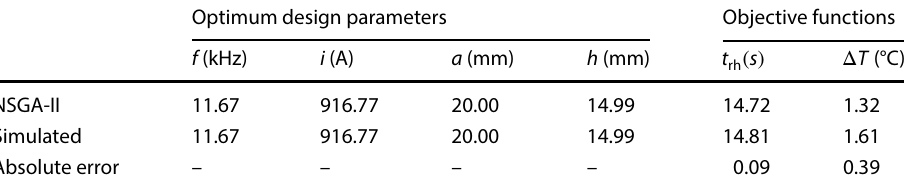
Table 6 Comparison of results obtained using hybrid multi- objective optimization and numerical simulation with optimum design